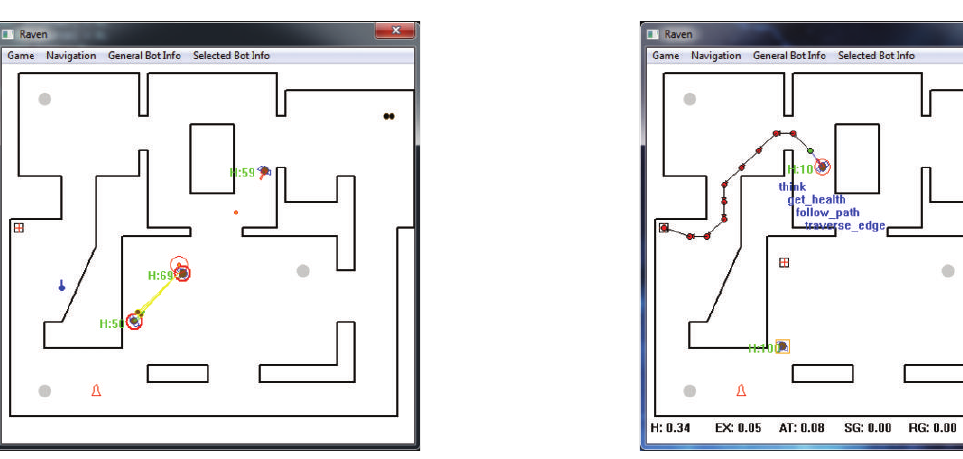
Figure 14: The AI information of a selected bot in Raven. Are shown are the goal stack, the path the bot is currently following, the current target of the bot (shown as a colored square around another bot) as well as a number of numerical desirabilities which indicate how important some of the actions the bot is thinking about are. From left to right, these are getting health, exploring, attacking the current target, getting a Shotgun, getting a Railgun and getting a Rocket Launcher.